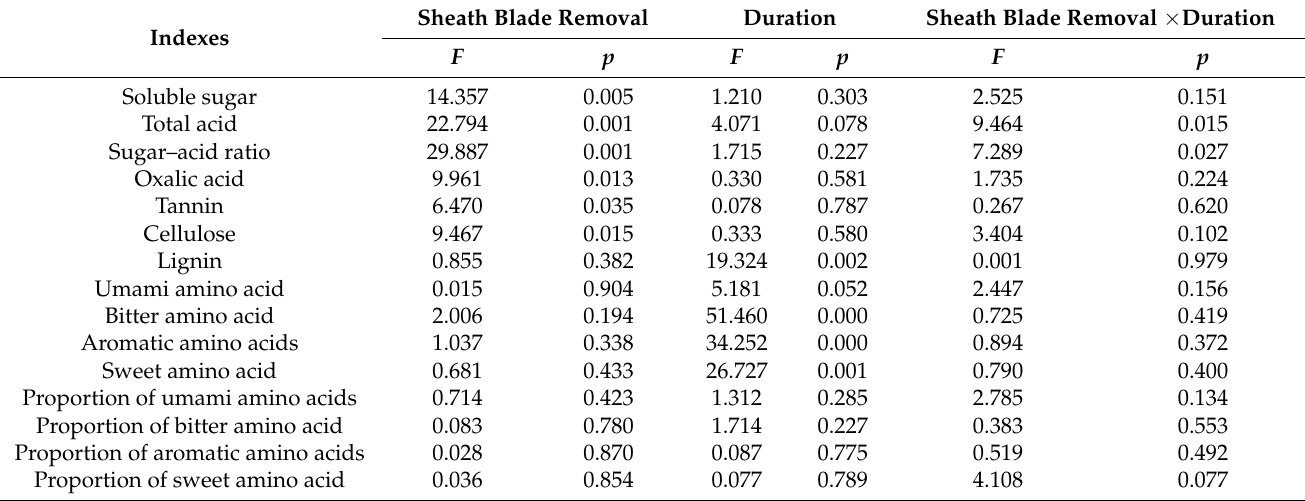
Table 4. Statistical two-way ANOVA results of sheath blade removal on flavor and roughness substances in Ph. violascens bamboo shoots.